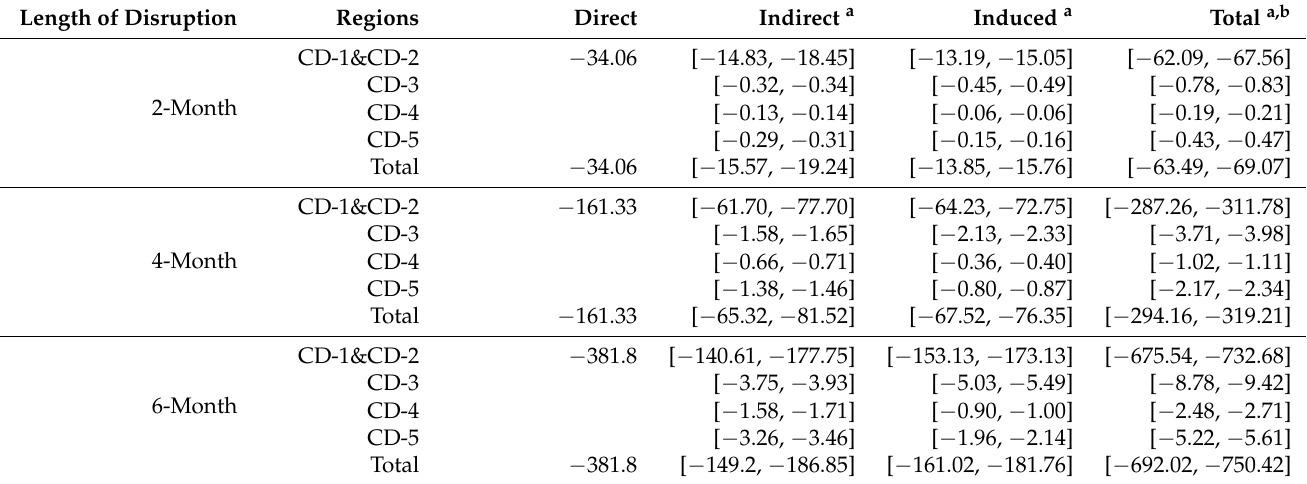
Table 8. Impact on loss in employment under different length of water transportation disruption.